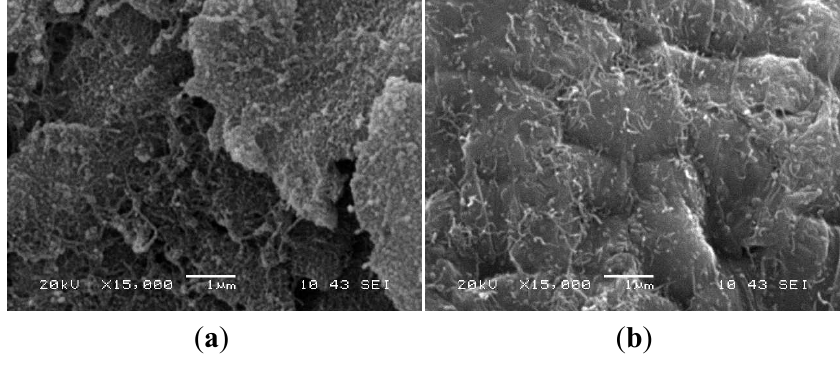
Figure 7. SEM micrographs of Al6061-1 wt% functionalized CNTs powder ( a ) after sonication and ( b ) after sonication and wet ball milling